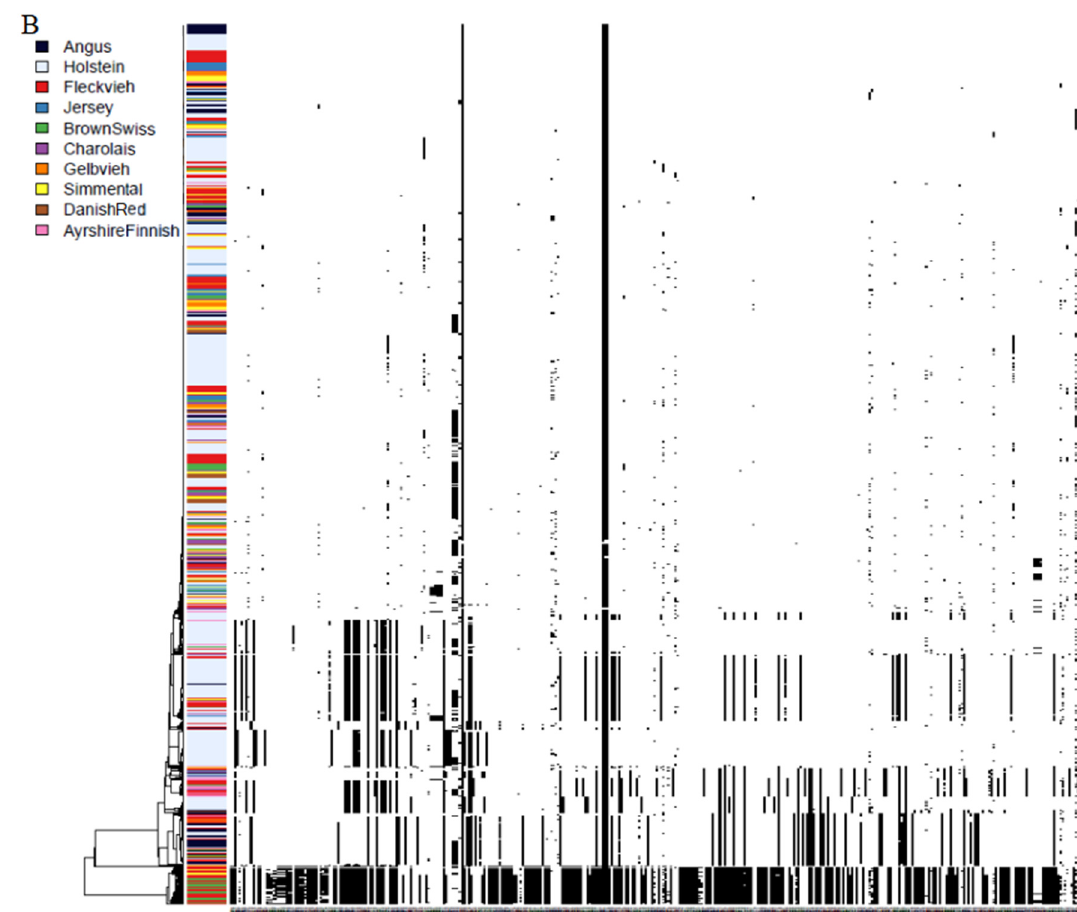
Figure 5. Haplotype structure and genealogies of haplotypes containing RERE variants located in ROH hotspots in different Bos taurus populations. ( A ) The structure and genealogies of haplotypes containing RERE gene. ( B ) The haplotype structure and genealogies in a non-ROH hotspot (chromosome 7:21,100,000–21,180,000 bp). The two alleles at each bi-allelic SNP are shown as black or white lines. Haplotypes are clustered based on based on the Manhattan distance, bringing together similar haplotypes and ordered by decreasing similarity. Breed association is indicated by the dendrogram on the left side.